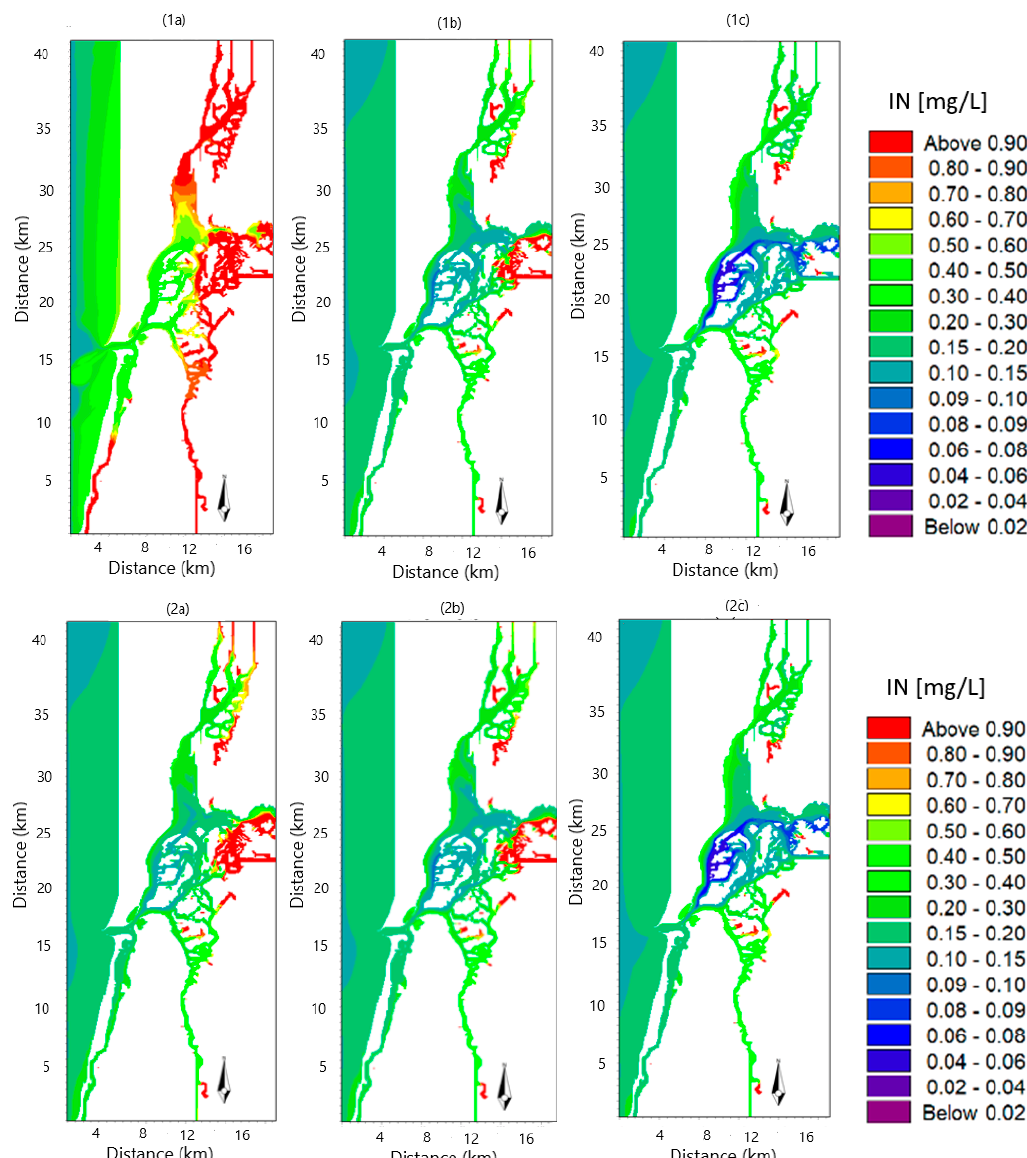
Figure 11. Snapshots of surface concentration of inorganic nitrogen, IN, for BS ( a ), SC1 ( b ), and SC2 ( c ), for two instants: 1—high tide, flooding at the lagoon mouth and ebbing at the mouth of the rivers (17/9/2000); 2—high tide, ebbing at the lagoon mouth and flooding at the mouth of the rivers (27/9/2000).